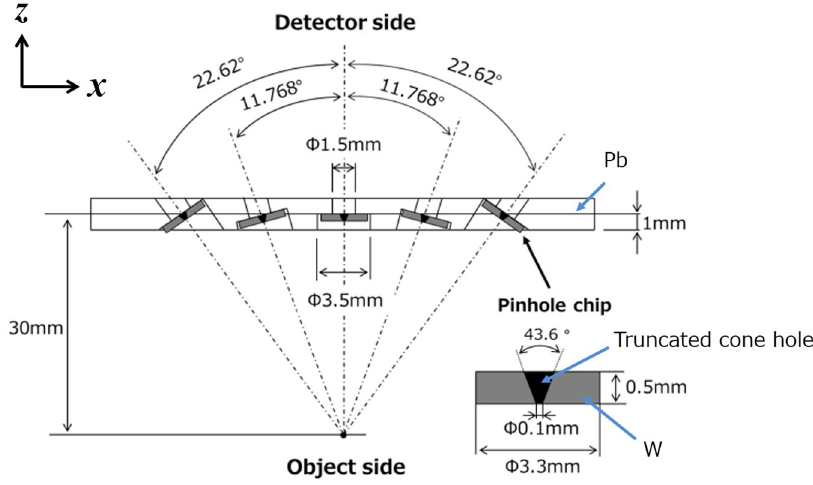
Figure 2. Cross-section of the Pb plate containing the centres of the pinholes and a W pinhole tip.